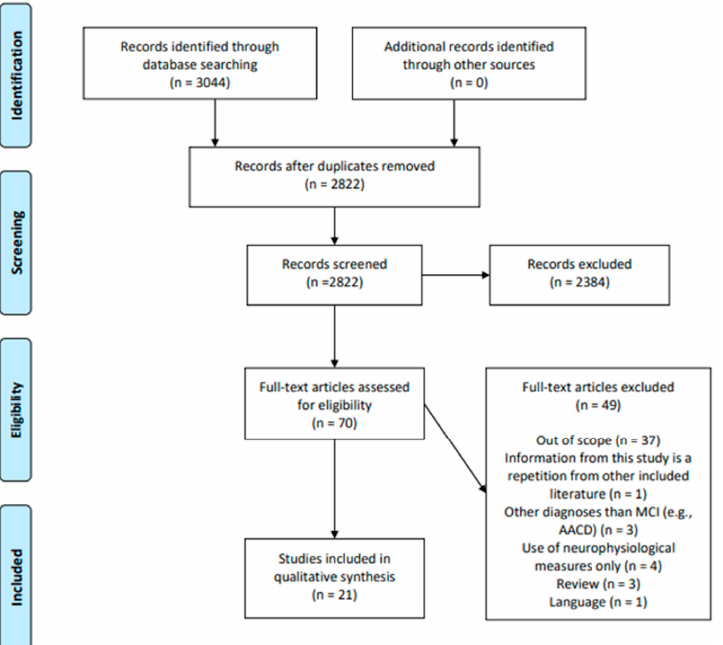
Figure 1. PRISMA flow